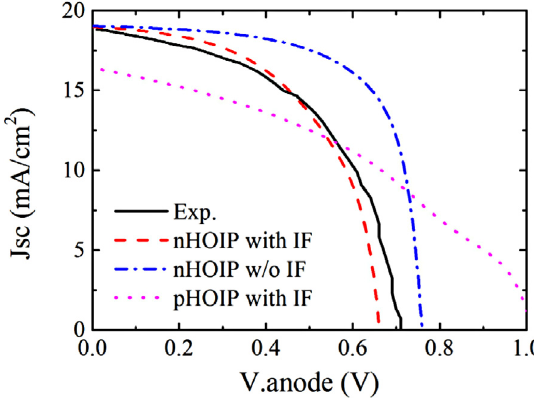
Fig. 5. J - V characteristics under 1 sun illumination of n-doped CH 3 NH 3 PbI 3 based HTM-free PSCs with (dash line) and with- out (dash dot line) interfacial layer (IF) The τ and μ of n-doped CH 3 NH 3 PbI 3 are equals to 80 ns and 0.2 cm 2 /Vs, respectively. And p-type CH 3 NH 3 PbI 3 is pictured by dot line as example with τ of 18 ns and μ of 0.2 cm 2 /Vs.